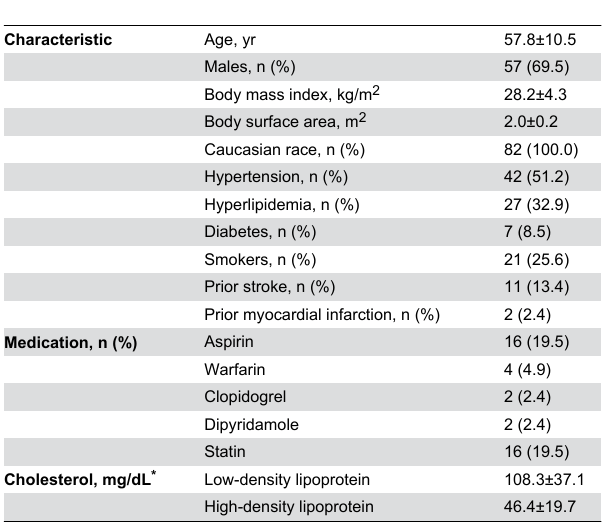
Table 3. Clinical Characteristics of 82 Patients with Acute Cryptogenic